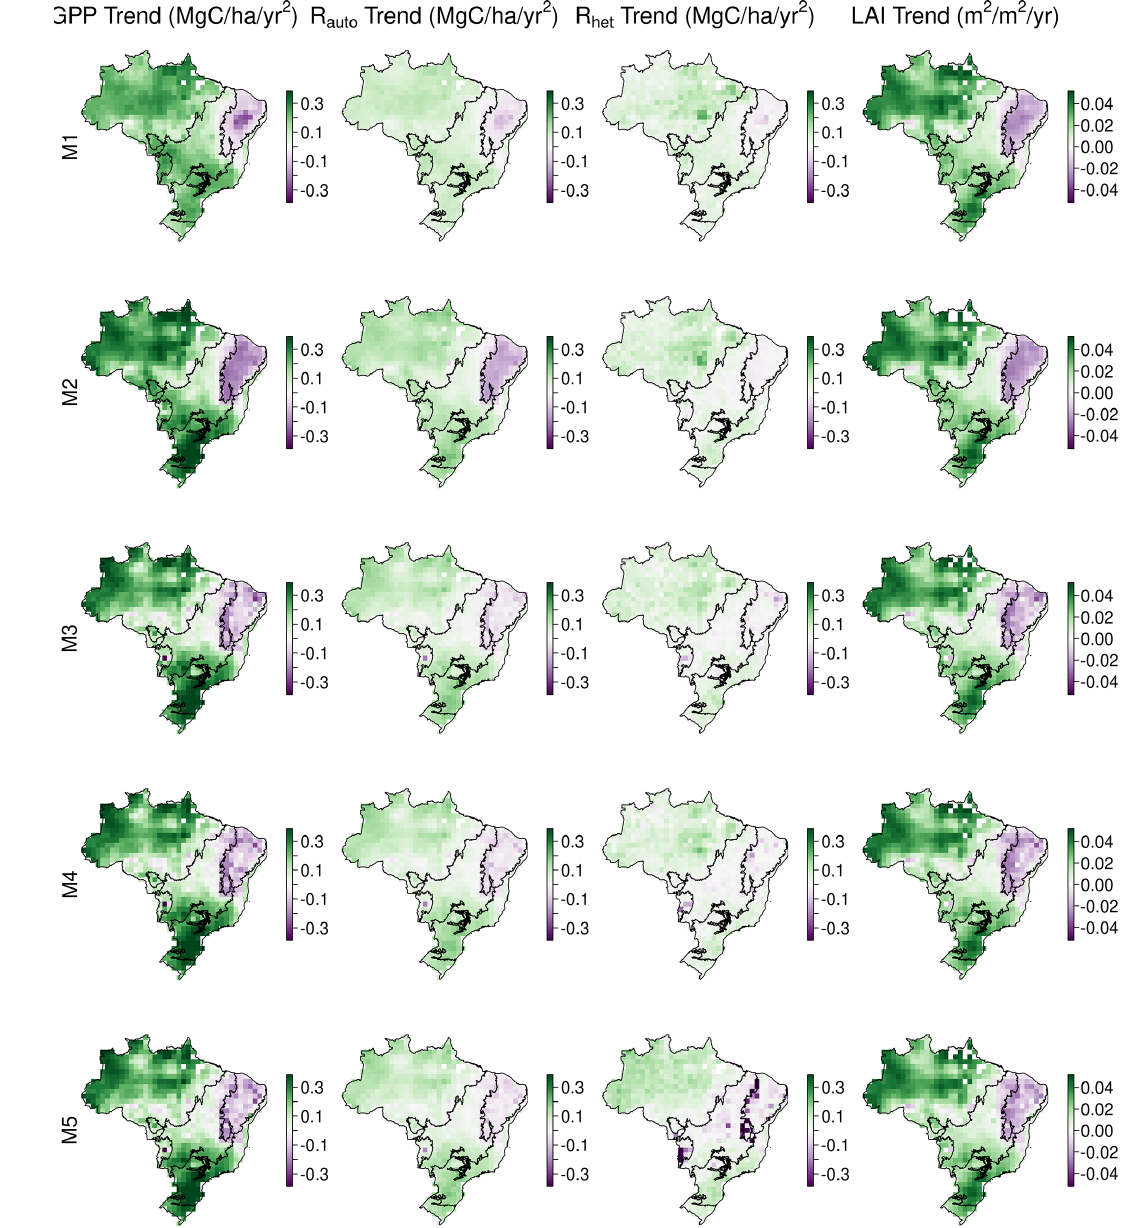
Figure A9. Model-specific trends (2001–2017) in GPP, R auto , R het , LAI estimated from the pixel-level median estimates.